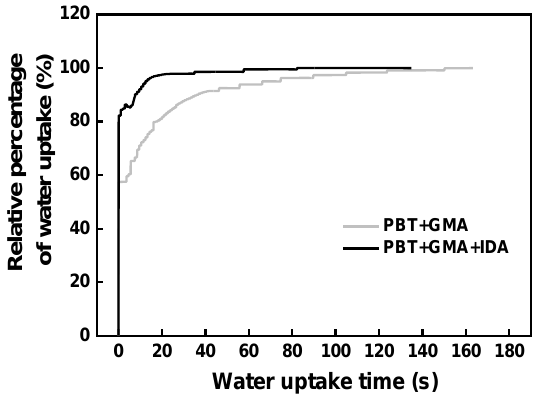
Figure 4. Relative percentage of water uptake (mass of water adsorbed at a given time divided by